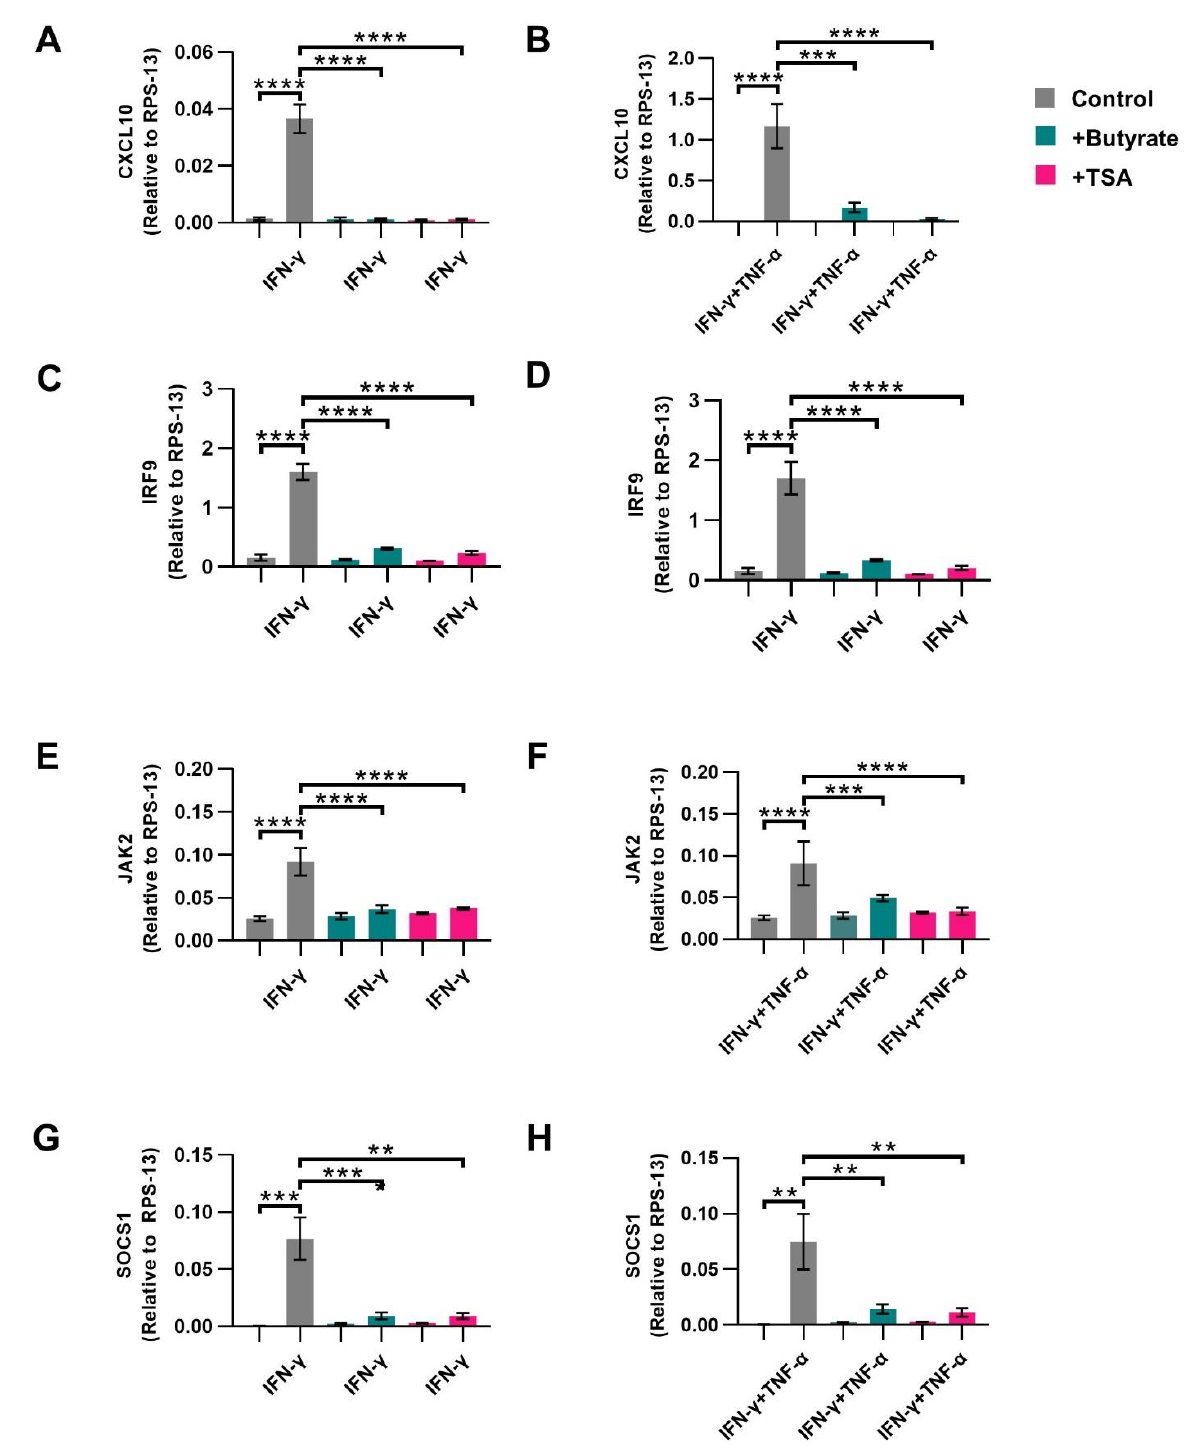
Figure 5. The effect of butyrate and histone deacetylase (HDAC) inhibitor Trichostatin A (TSA) on mRNA expression of genes related to the STAT1 signaling cascade. Intestinal epithelial cells were activated with IFN- γ or IFN- γ +TNF- α and treated with 2 mM butyrate (green bars) or 10 μM TSA (pink bars) for 4 h. mRNA expression was measured in CXCL10 ( A , B ), IRF9 ( C , D ) JAK2 ( E , F ) and SOCS1 ( G , H ). Data are represented as mean ± SEM ( n = 4). Significant differences are shown as ** p < 0.01, *** p < 0.001, **** p < 0.001 Control compared to butyrate, TSA, IFN- γ ( A , C , E , G ) or IFN γ+TNFα ( B , D , F , H ) activated cells and activated cells compared to butyrate or TSA treated activated cells.